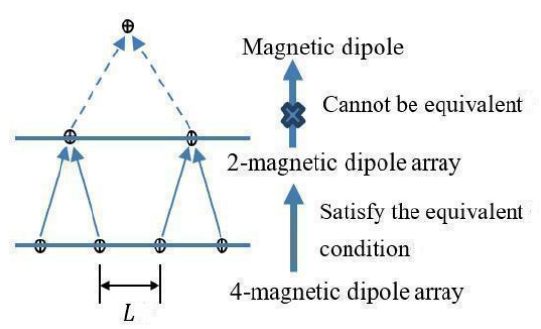
Figure 8. Layer-by-layer equivalent diagram of the multi-magnetic dipole